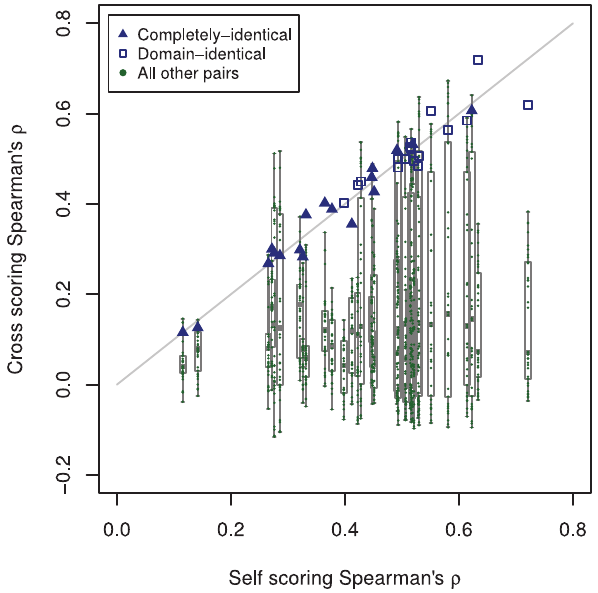
Figure 5. Self and cross Spearman correlation coefficients ( r ) between position weight matrix-based scores and experimen- tal PBM fluorescence intensities. The blue points are the completely-identical and domain-identical transcription factor pairs of Figure 1. The alignment of blue points along the gray diagonal line demonstrates the comparable performance of PWMs derived from completely-identical and domain-identical transcription factor pairs, whereas the magnitude of r is an indication of how well the PWM captures the DNA binding properties of the transcription factor. As a point of comparison, the correlation coefficients for all other pairwise sets of transcription factors were calculated. The green points below the gray diagonal are indicative of PWMs from other transcription factors that failed to capture the DNA binding properties in the PBM data. Green points near the diagonal resulted from other transcription factors within the same domain family ( e.g. , homeodomain) that have similar PWMs and, therefore, DNA binding properties. UniPROBE identifiers UP00017 and UP00389 were significantly outperformed by other PWMs in the data set (see text for